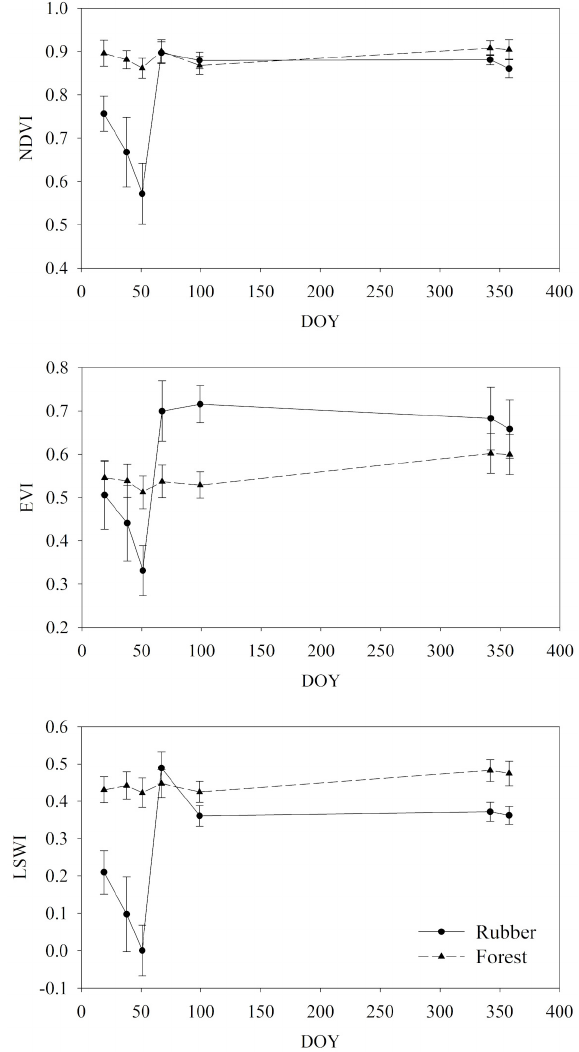
Figure 3. The time series of Landsat images derived from NDVI, EVI, and LSWI for rubber plantations and natural forests; 50 points of rubber plantations and 50 points of natural forests were used. DOY is the day of the year.